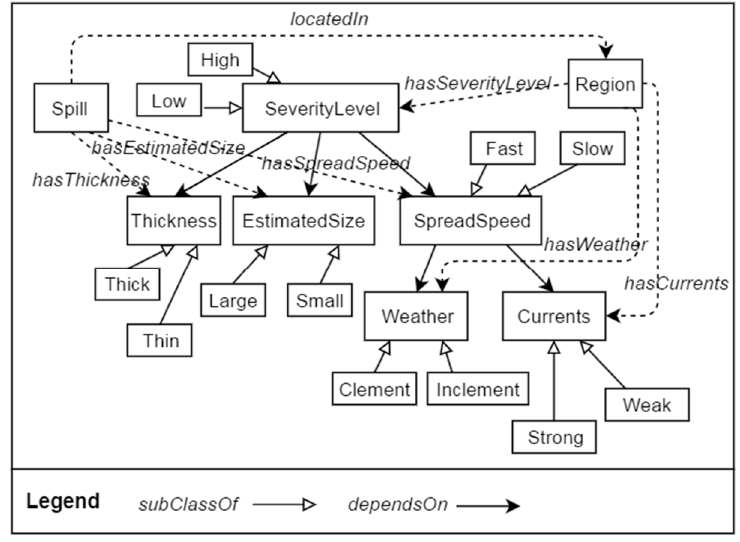
Figure 5. Application ontology extensions for representing the scenario.